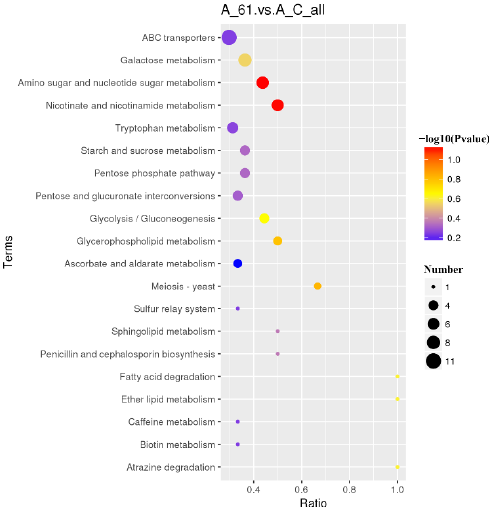
Figure 12. Bubble chart of KEGG enrichment results of differential metabolites between mutant 61 and the original strain. The size of the bubble indicates the number of genes enriched in the path ‐ way.